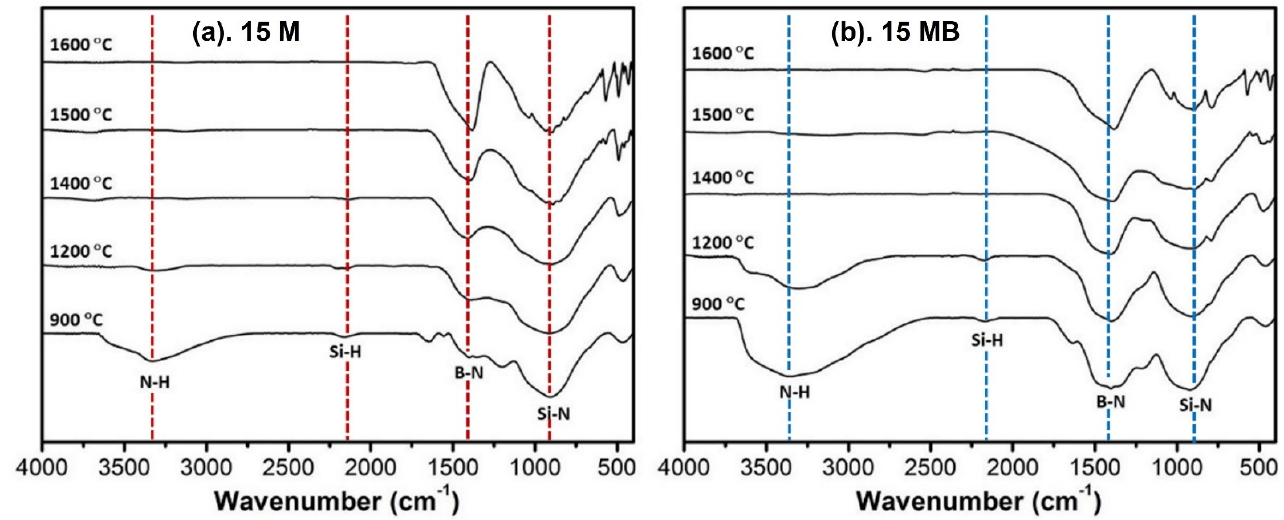
Figure 8. FT-IR spectra of the pyrolysis products of ( a )15 M and ( b )15 MB at 900~600 °C.